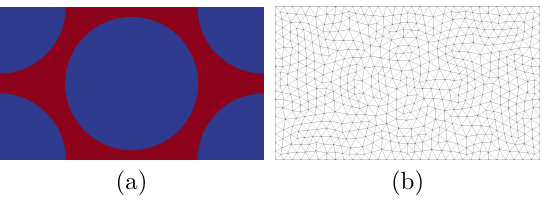
Figure 1. a) PUC with PHA, b) example of